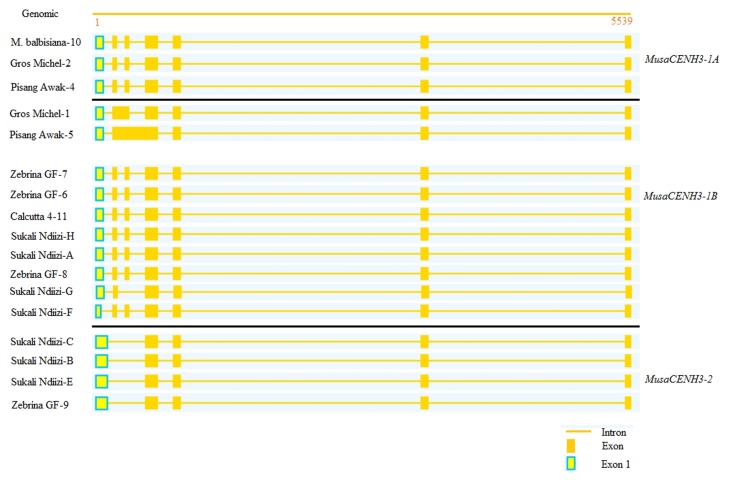
Alignment of the CENH3 transcripts to genomic sequence of genotype ‘DH Pahang’ to identify splice mechanisms. The 7/6, 6/5, and 5/4 structures are represented intron/exon structures are represented. Alignment was performed using Splign (Kapustin et al., 2008).